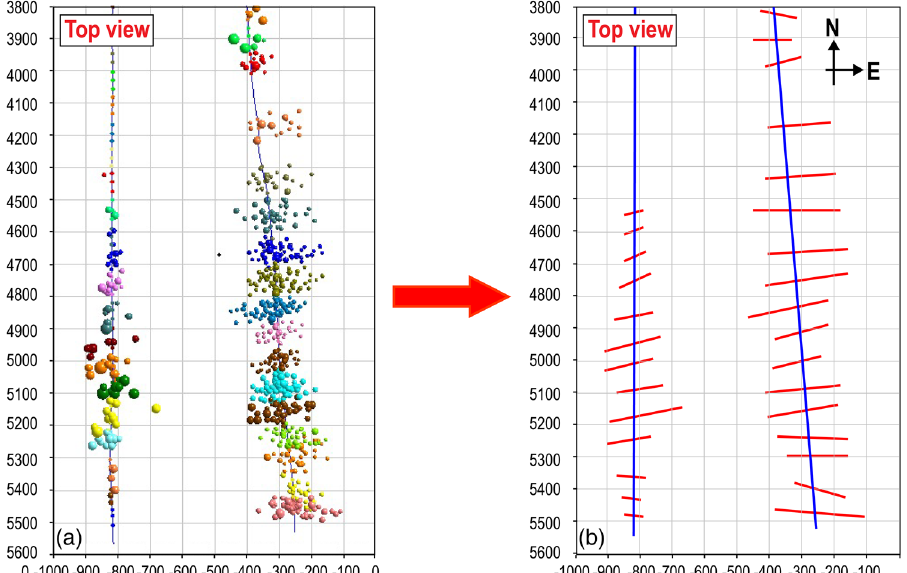
Fig. 1 Hydraulic fractures gen- erated by integrated RANSAC based on the microseismic